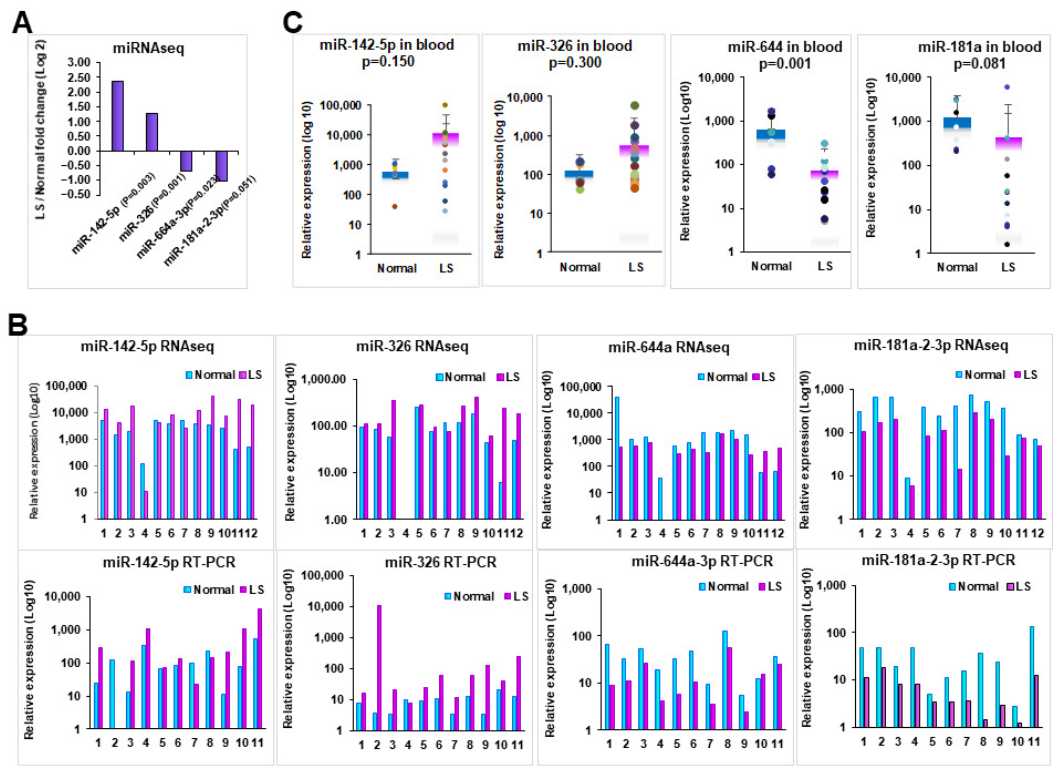
Figure 2. Expression analysis of selected candidate miRNAs in tissue and blood samples. ( A ) Expression of represented miRNAs by RNASeq analysis. ( B ) Expression comparison of dysregulated miRNAs between by RNASeq and qRT-PCR. ( C ) Expression of representative miRNAs in blood samples from patients with LS compared with healthy female volunteers. p -values were calculated for statistical significance as indicated for each comparison.